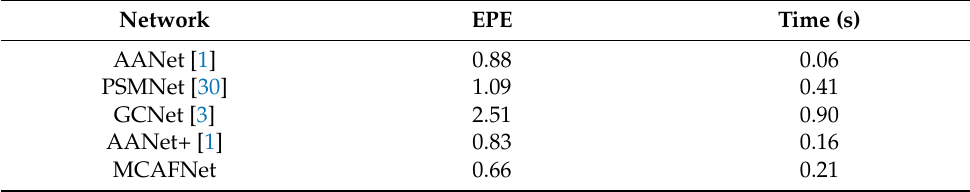
Table 3. Comparison of indicators of different networks on the Scene Flow